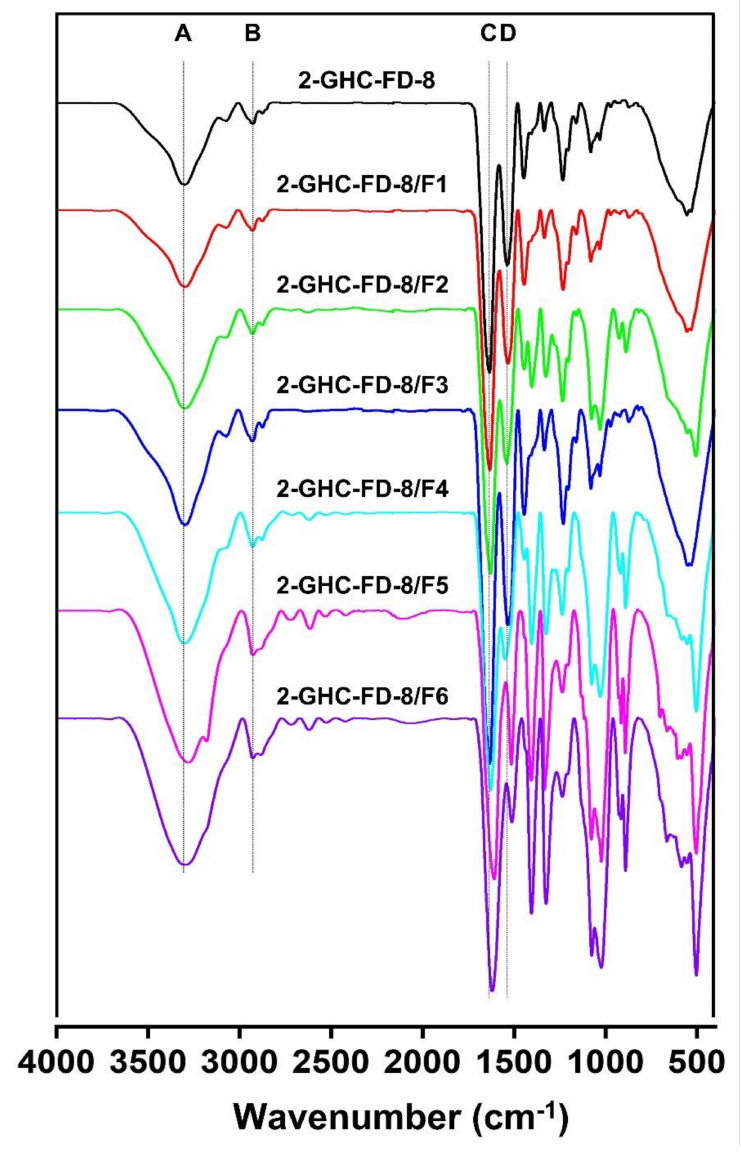
Figure 6. FTIR spectra of 2-GHC-FD-8/F1-6 monitored from 400 to 4000 cm − 1 . A, B, C, and D indicate OH, CH, C=O/amide I, and amide II signals,